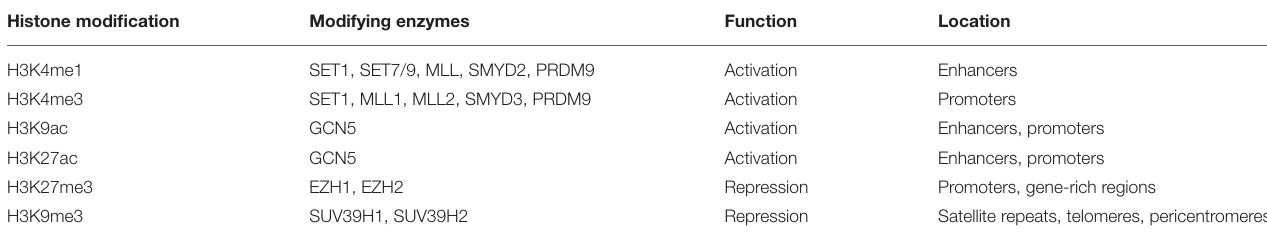
TABLE 1 | Effects of the most frequent histone changes in gene